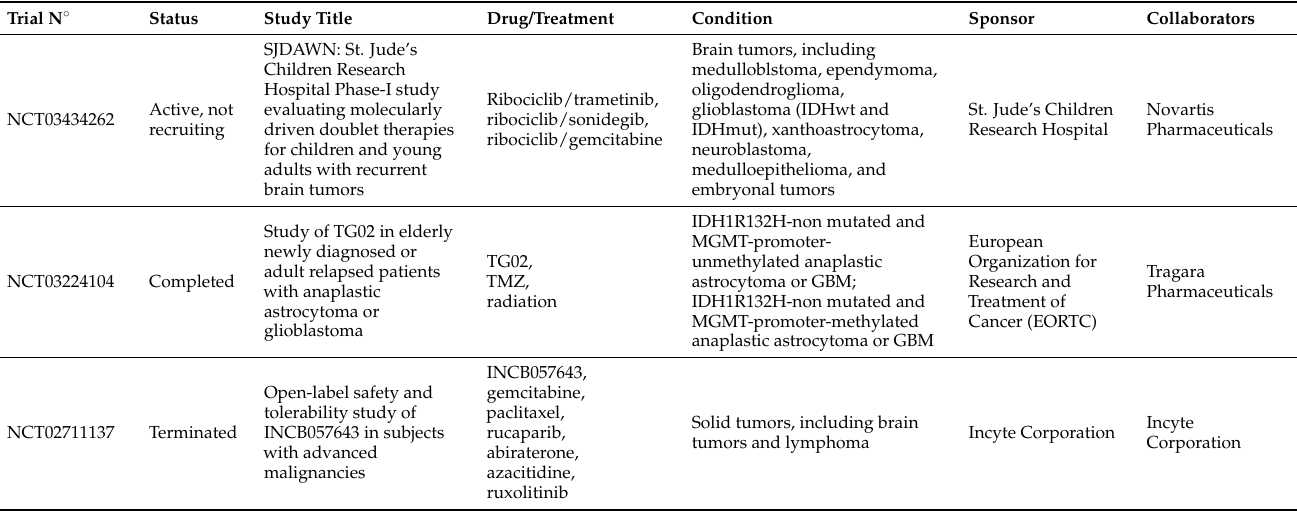
Table 1. Clinical trials related to Myc overexpressing brain